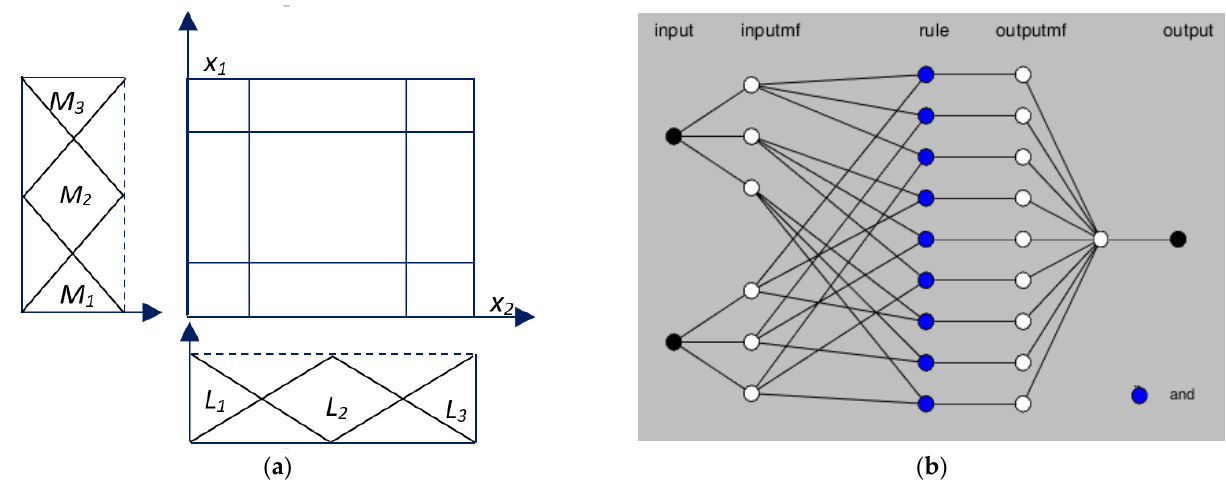
Figure 5. ( a ) Partition of the input space; ( b ) ANFIS model based on partition with 3 fuzzy sets.